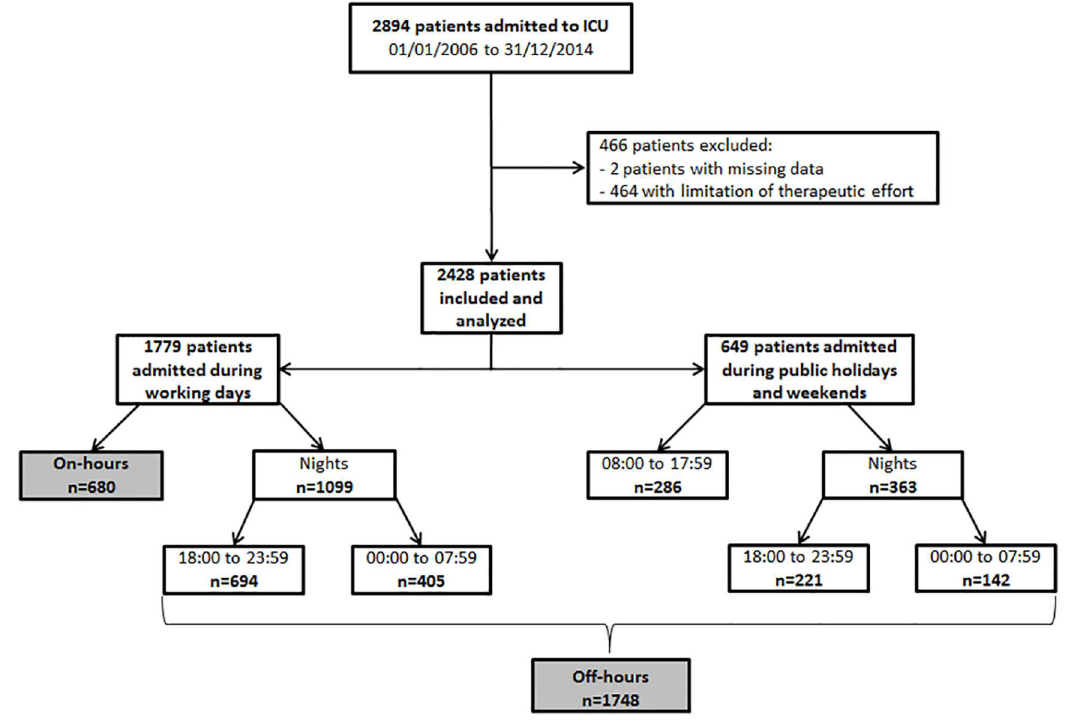
Fig 1. Flow-chart of the study